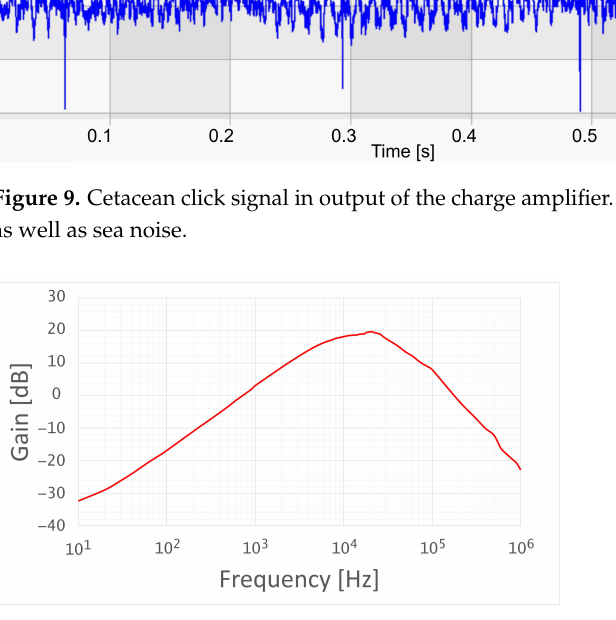
Figure 10. High-pass active filter measured frequency